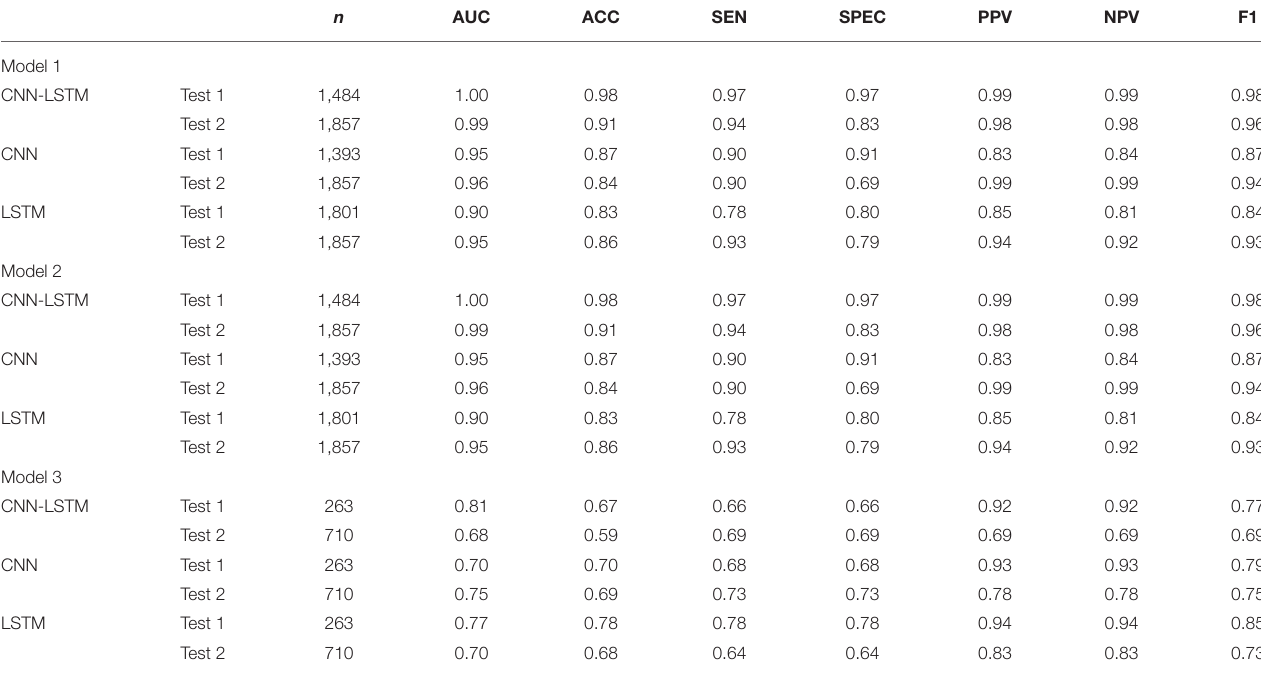
TABLE 3 | Diagnosis performance of CNN-LSTM, CNN, and LSTM between internal and external test. n AUC ACC SEN SPEC PPV NPV F1